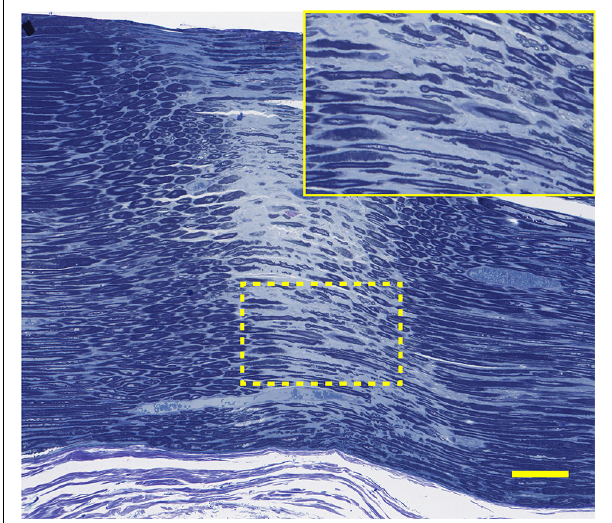
FIGURE 12 | Histology corresponding to the CMAP tracing of 5D: this longitudinal section through the narrow nerve crush zone with distinct borders shows sparing of some small nerve fibers in the gap. Lesion width is ∼ 300 µ m. Bar = 100 µ m, insert is an enlargement of the dotted line region.